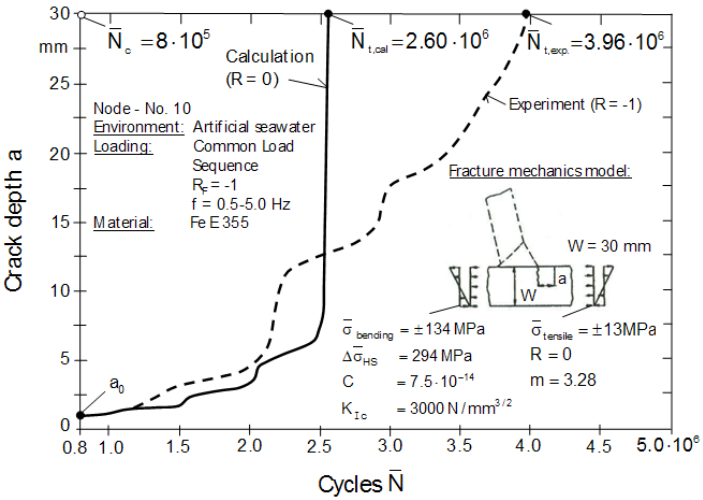
Figure 12: Crack propagation in the chord of a K-node.